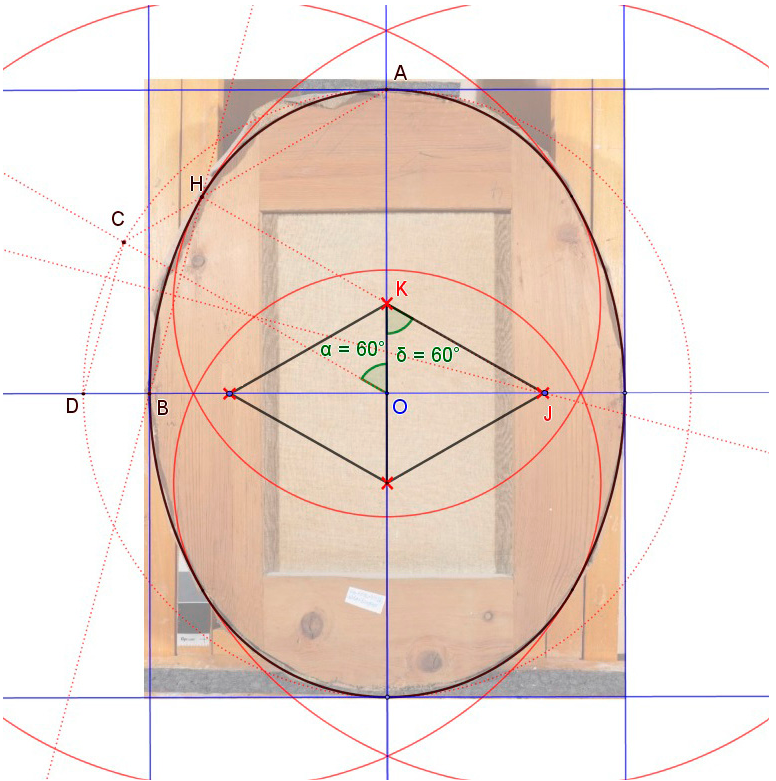
Figure 13. The Huygens construction applied to the strainer of A.M.B. Neergaard (SV2) (illustration courtesy of Angelo Alessandro Mazzotti). The construction presents an oval inscribed in a rectangle with two equilateral triangles, as the straight lines connecting two centres on the different axes form an angle of 60° (pi/3 radians). The arcs share a common tangent because K, H and J are co-linear.